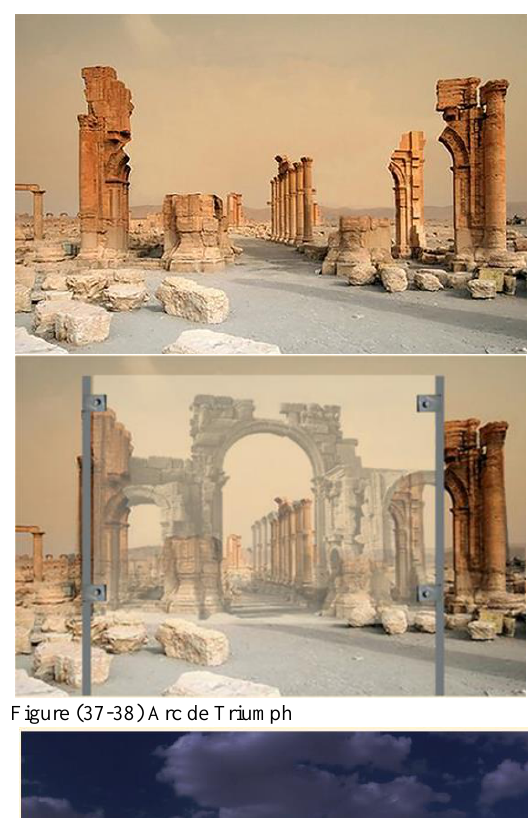
Figure(42-43 ) The cemeteries/wadi al-Qabour